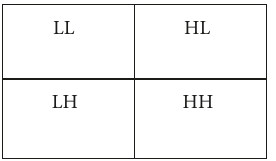
Figure 1: First order wavelet